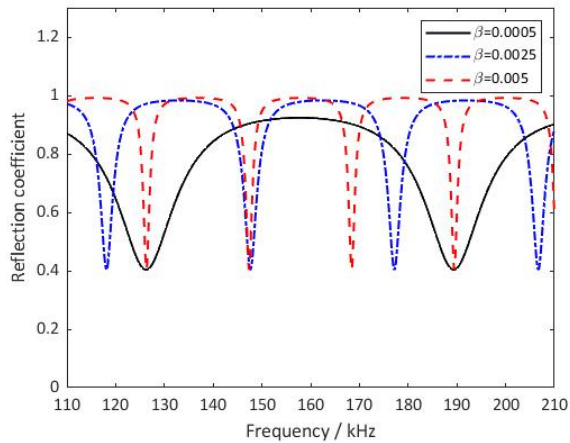
Figure 5. Frequency response of acoustic reflection coefficients in multilayer media of human tissue containing bubbly liquid layers at different gas contents.